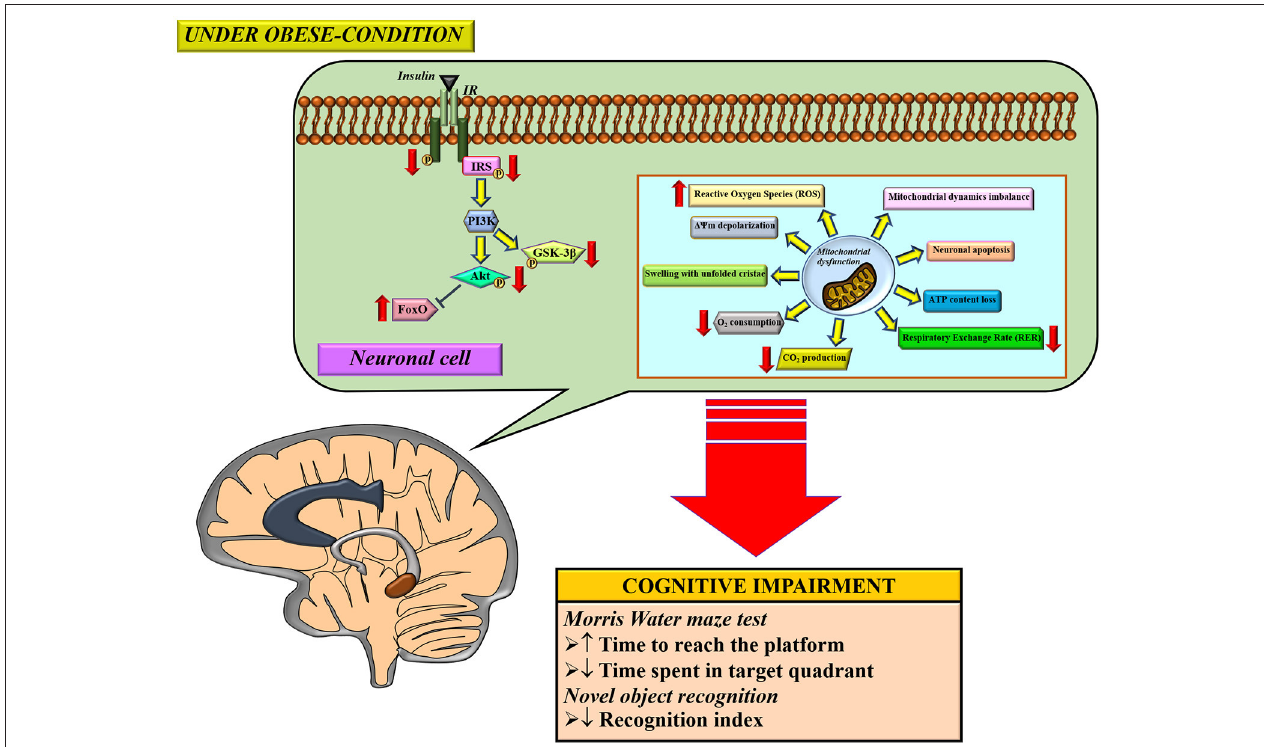
FIGURE 3 | The proposed mechanisms of obese-insulin resistance and brain mitochondrial dysfunction induced brain cognitive decline. Under obese-condition, brain insulin signaling was initially impaired by a reduction of insulin receptor (IR) phosphorylation which led to further its downstream signaling cascade including decreasing phosphorylation of the insulin receptor substrates (IRS), Akt and GSK3 β . On the other hand, the reduction in Akt phosphorylation subsequently decreased an inhibitory response to FoxO protein, resulting in an increased FoxO expression. In parallel with impaired brain insulin signaling pathways, brain mitochondrial dysfunction was also observed as indicated by several anomalies in function changes (increased ROS production, 19 m depolarization, in association with decreased O 2 consumption, CO 2 production and respiratory exchange rate (RER), and thus induced loss of ATP content), morphological changes (mitochondrial swelling and unfolded cristae), dynamics changes (imbalance of mitochondrial fusion and fission proteins expression), and causing neuronal apoptosis. Eventually, all these pathological changes can lead to cognitive impairment, determined by learning and memory behavior tests. 19 m; mitochondrial membrane potential, ATP; adenosine triphosphate, FoxO, forkhead box O; GSK-3 β , glycogen synthase kinase-3-beta; IR, insulin receptor; IRS, insulin receptor substrate.